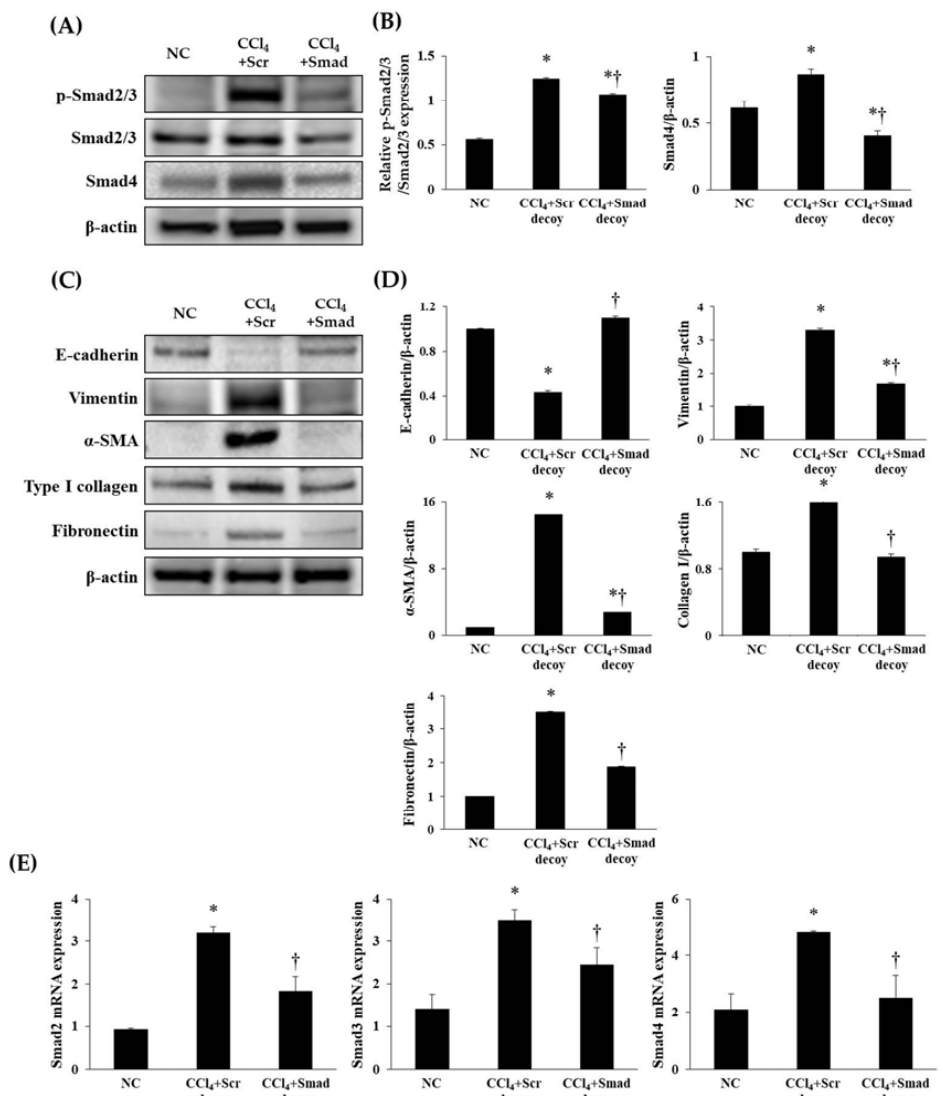
Figure 5. Synthetic Smad decoy ODN significantly suppressed fibrotic genes and ECM proteins by blocking the Smad-dependent signaling pathway. ( A ) Western blot data showed that Smad decoy ODN suppressed the expression of p-Smad2/3 and Smad4. All samples were loaded equal volumes, which was confirmed by loading GAPDH together; the results are representative of three independent experiments; ( B ) The expression levels of the protein from quantification of these images by Image J. ( C ) The expressions of E-cadherin, vimentin, α -SMA, type I collagen, and fibronectin as the representative of three independent experiments; ( D ) quantification of ECM proteins; and ( E ) qRT-PCR analysis that showed that Smad decoy ODN inhibited the mRNA expression of Smad2, Smad3, and Smad4. * p < 0.05 compared to normal control group; † p < 0.05 compared to the CCl 4 +Scr group.